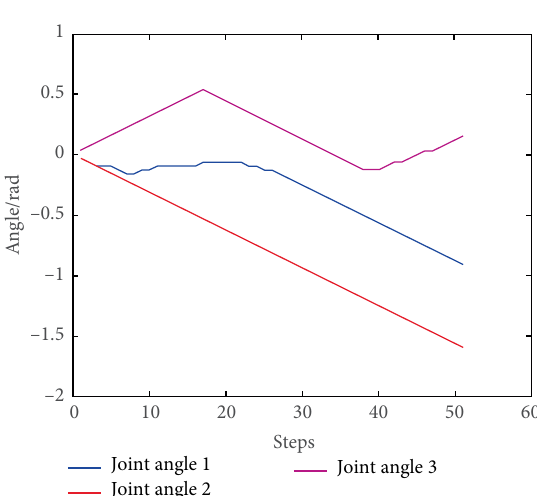
Figure 4: Path plan of three